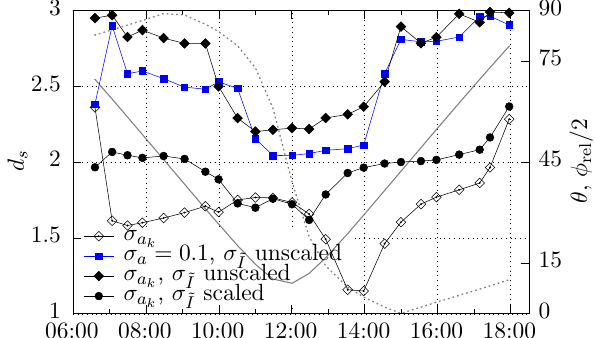
Fig. 12. As Fig. 8, but here for the ground layer profile with τ ∼ 1.2 and choice of the regularisation parameter as in Eq. (19). Shown are cases without ˜ I (open symbols), with ˜ I and fixed σ ˜ (squares and I diamonds) and scaled σ ˜ according to Eq. (20) (filled I